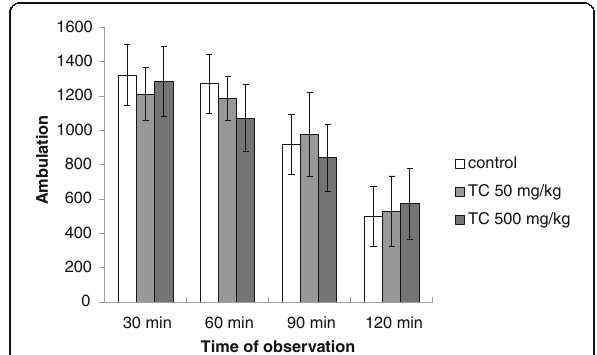
Fig. 1 Spontaneous locomotor activity of mice treated acutely with Trichilia catigua (TC) hydroalcoholic extract at doses of 50 and 500 mg/kg (p.o.). The columns and bars represent the means ± SEM ( n = 10). ANOVA,